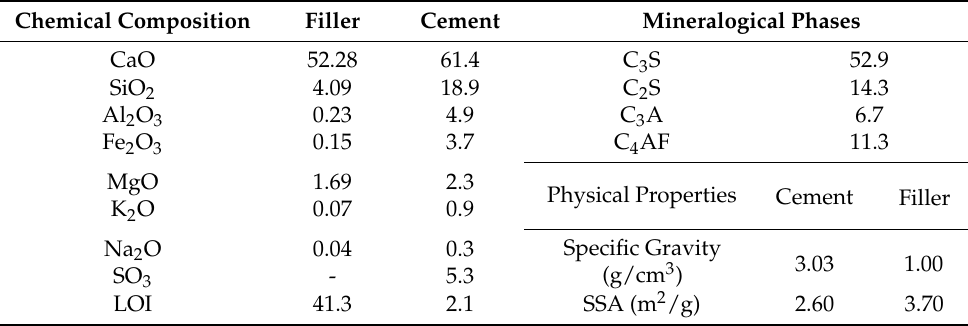
Figure 3. PSD of PC and limestone filler used in the PPM FRCA mixtures. Table 3. Physicochemical characterization of GU cement and limestone